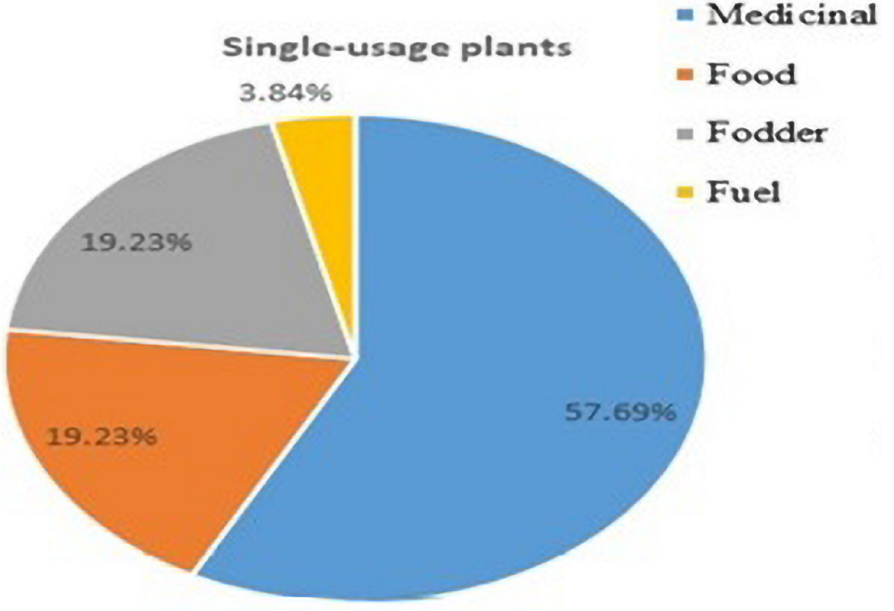
Fig 4. A pie-chart of single-usage on the basis of their usage from study area of Dawarian and Rati Gali, District Neelam of Azad Jammu and Kashmir, Pakistan.